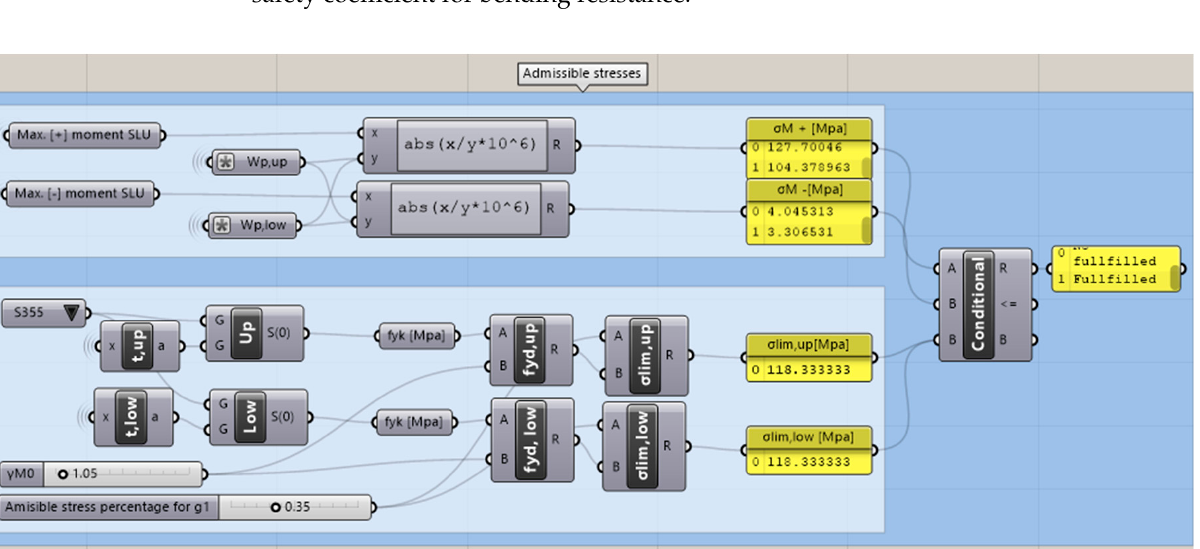
Table 6. Mechanical properties of structural steels produced to EN 10025, under EN 1998-1-1.